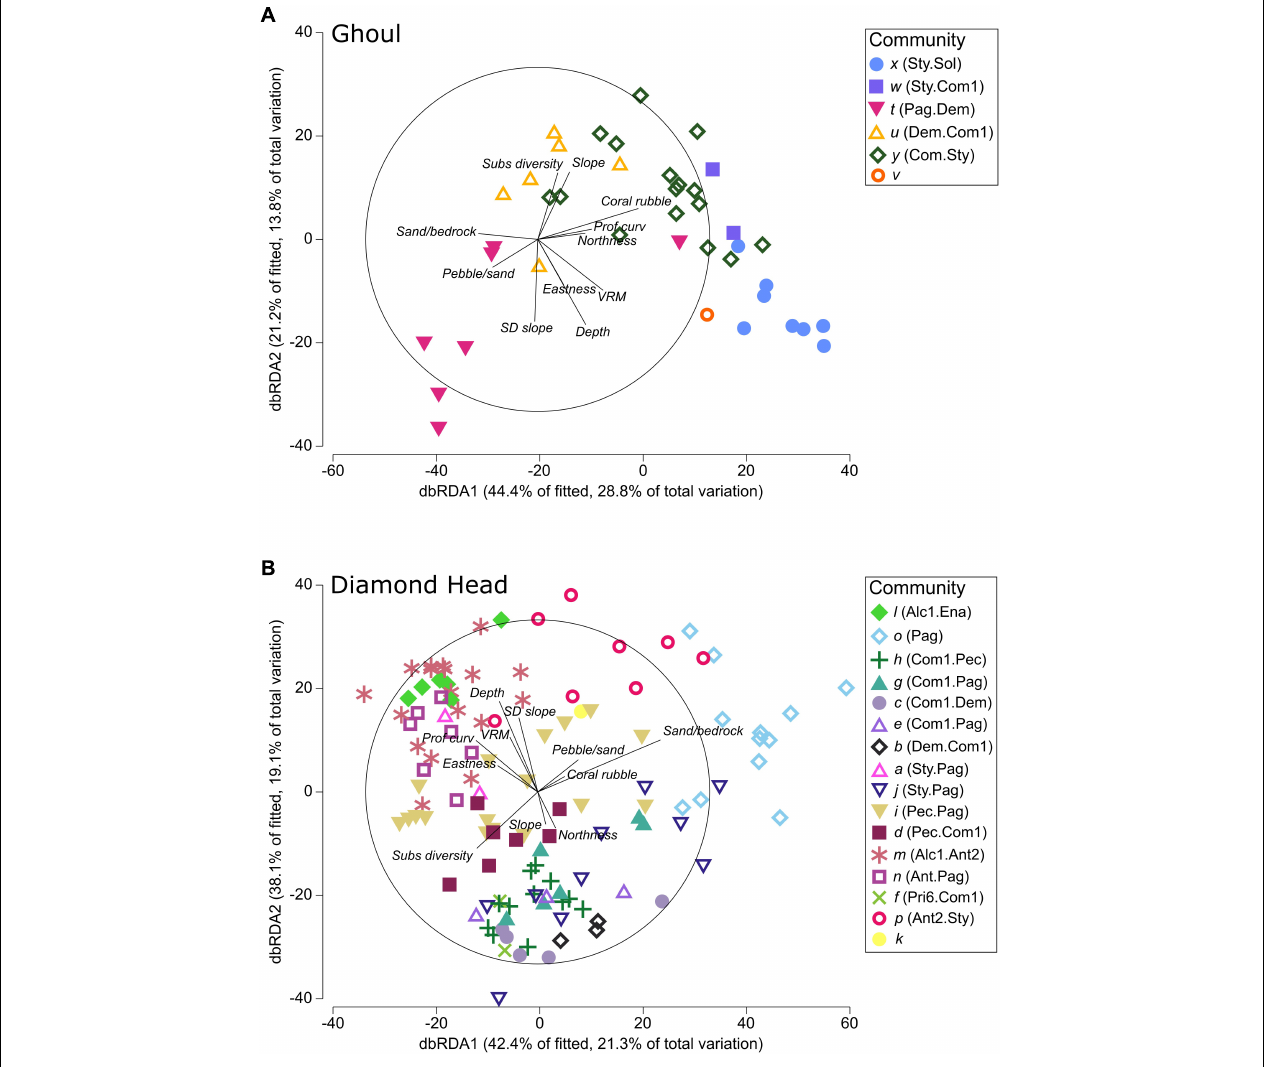
FIGURE 5 | Distance-based redundancy (dbRDA) plots of the best models selected using distance-based linear modelling (DistLM) to fit the community data to the environmental data for (A) Ghoul and (B) Diamond Head. The magnitude of each vector indicates the proportional contribution of each variable to the total variation between samples. Variable abbreviations are as follows: SD slope, standard deviation of slope; subs diversity, substrate diversity calculated as Hill’s N2; Prof curv, profile curvature; VRM,